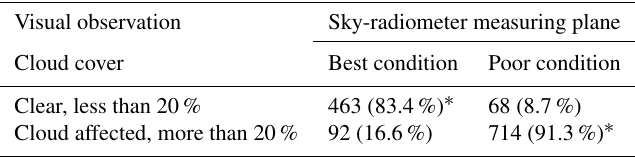
Table 3. Validation of the SCAD method by visual observation from 2013 to 2014 in Tsukuba.